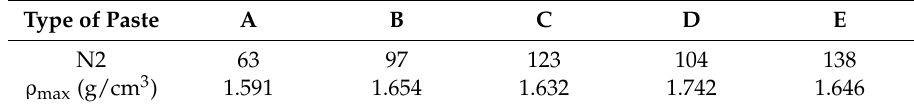
Table 5. Rammability index N2 and maximum density ( ρ max ).